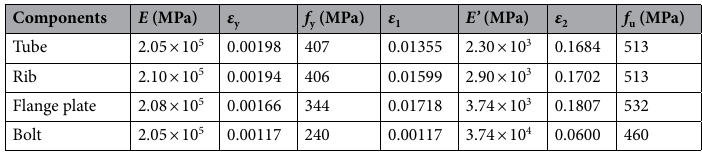
Table 3. Material properties of components.